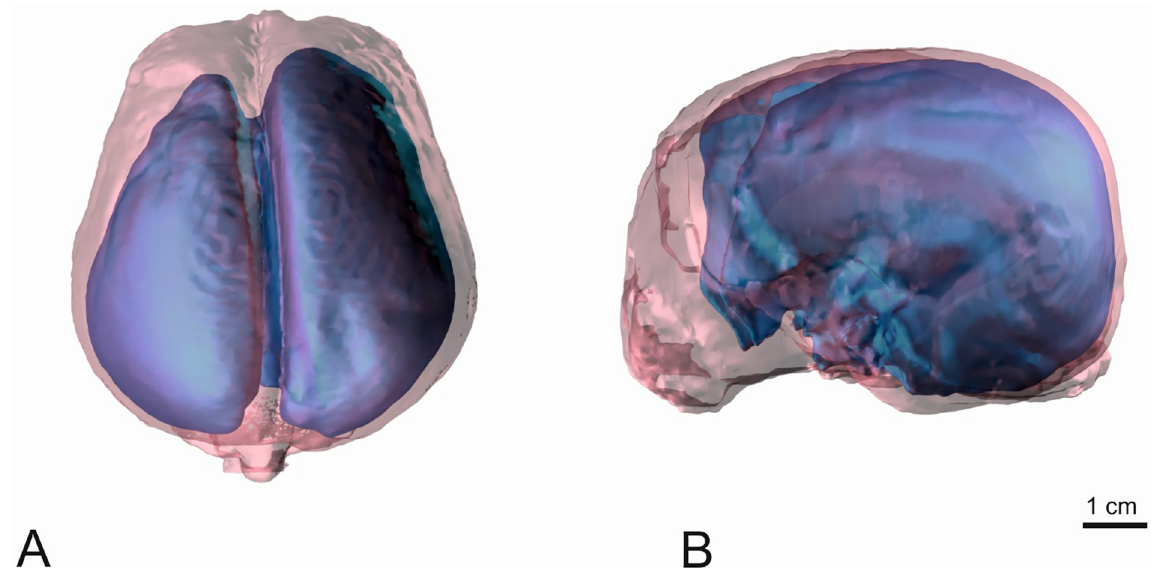
Fig 2. 3D model of thebrain and ventricular volume of a Pomeranian with triventricular internal hydrocephalus. The voxels of the tissue of interest (skull: white, transparent, brain: red, transparent, lateral ventricles: blue) of each slice have been assembled and are displayed as a 3D model. A: dorsal view, B left lateral